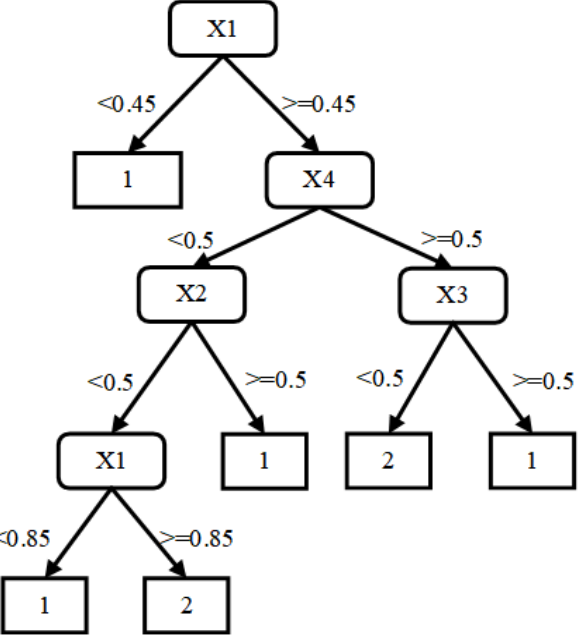
Figure 6. Decision tree model 2(b) with minimum cross-validation